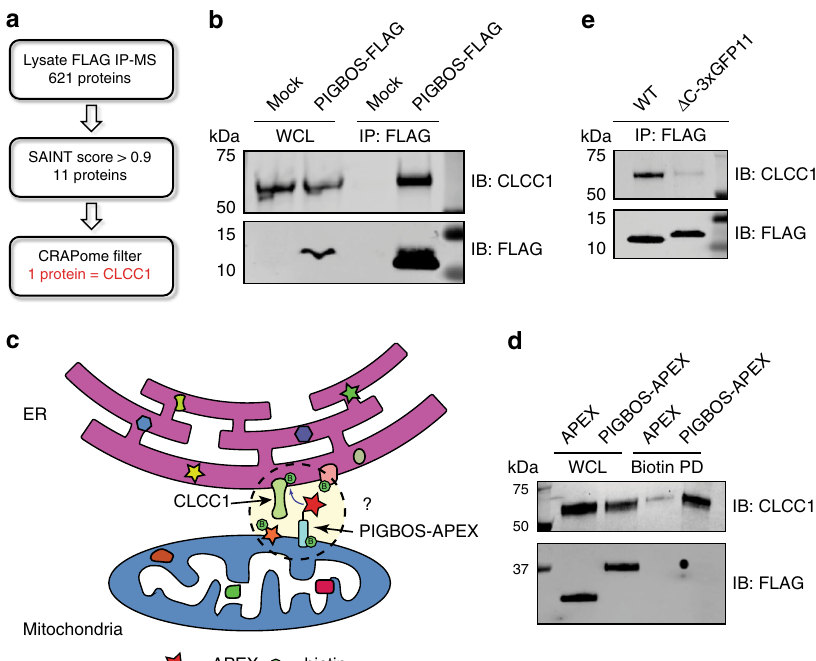
Fig. 3 PIGBOS interacts with the ER protein CLCC1. a Analysis of the PIGBOS-FLAG IP-MS to remove false positives and background proteins yielded CLCC1, an ER-resident protein, as a PIGBOS interacting protein. b Co-immunoprecipitation of PIGBOS-FLAG enriched CLCC1 from HEK293T total cell lysates. c A PIGBOS-APEX construct was used to proximity label the proteome and determine whether PIGBOS and CLCC1 are near each other in living cells. d Enrichment of CLCC1 in PIGBOS-APEX labeling proteome indicated that it was biotinylated and, therefore, in proximity to PIGBOS-APEX. e Replacement of the PIGBOS C-terminal region with 3 × GFP11 (PIGBOS- Δ C-3 × GFP11-FLAG) prevented enrichment of